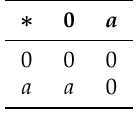
Table 1. Cayley table for the binary operation “ ∗ ”.